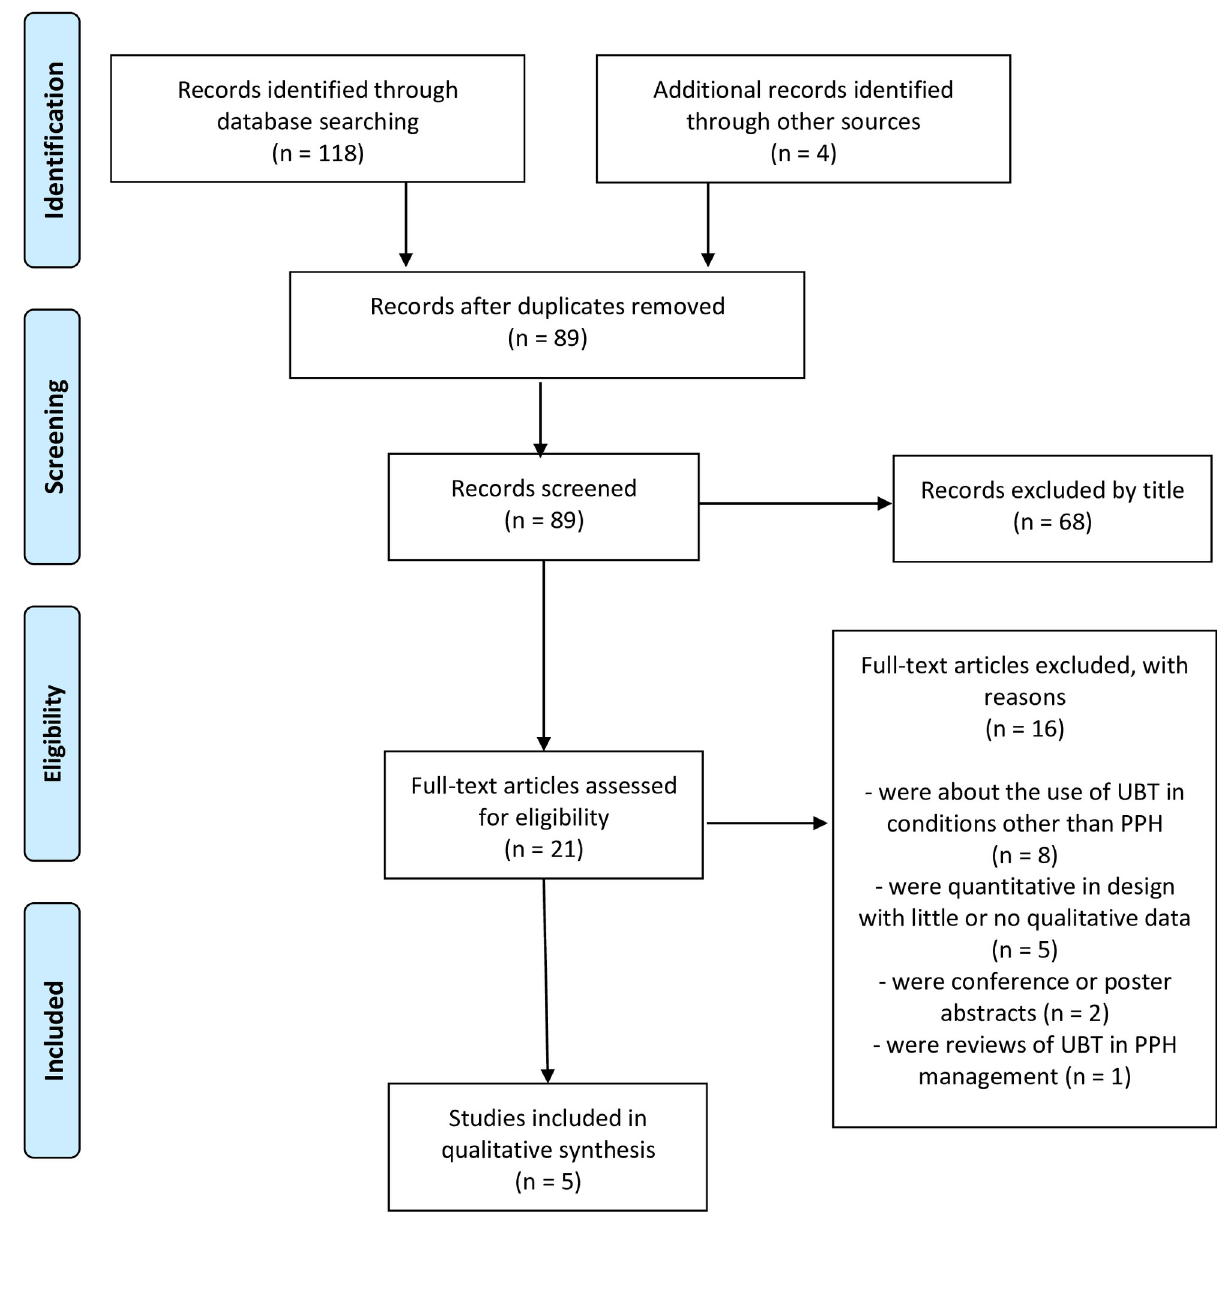
Fig 1. PRISMA flowchart goes